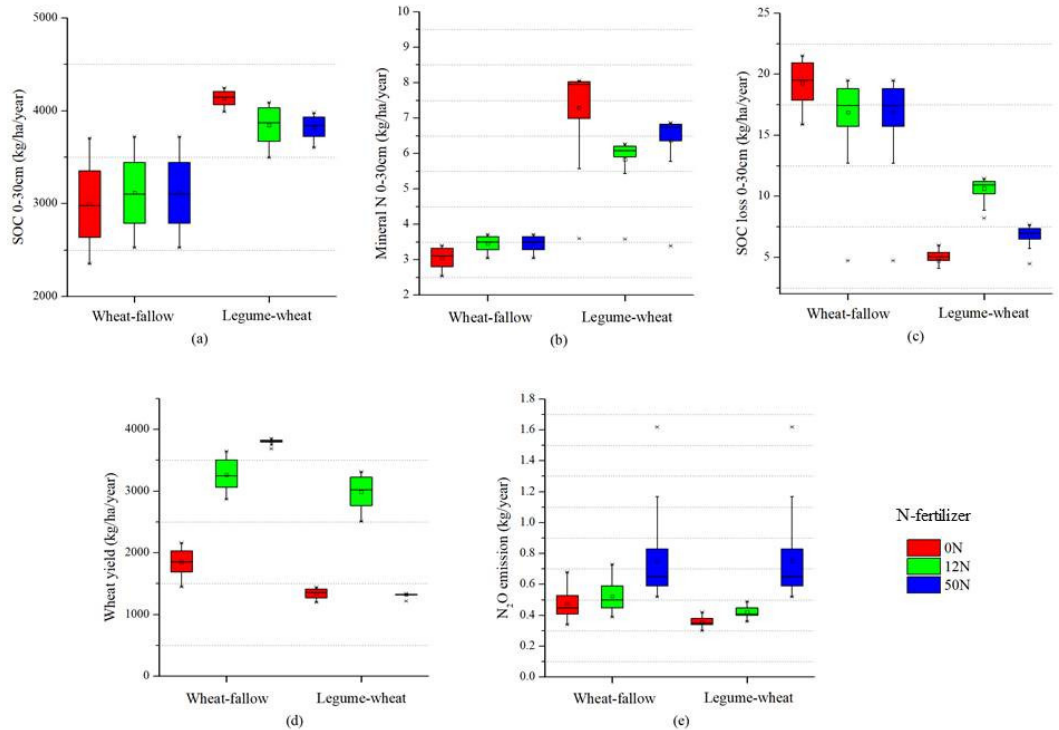
Figure 7. Influence of fertilization rate on ( a ) SOC (0–30 cm), ( b ) mineral N (0–30 cm), ( c ) SOC loss (0–30 cm), ( d ) wheat yield, and ( e ) N 2 O emission.